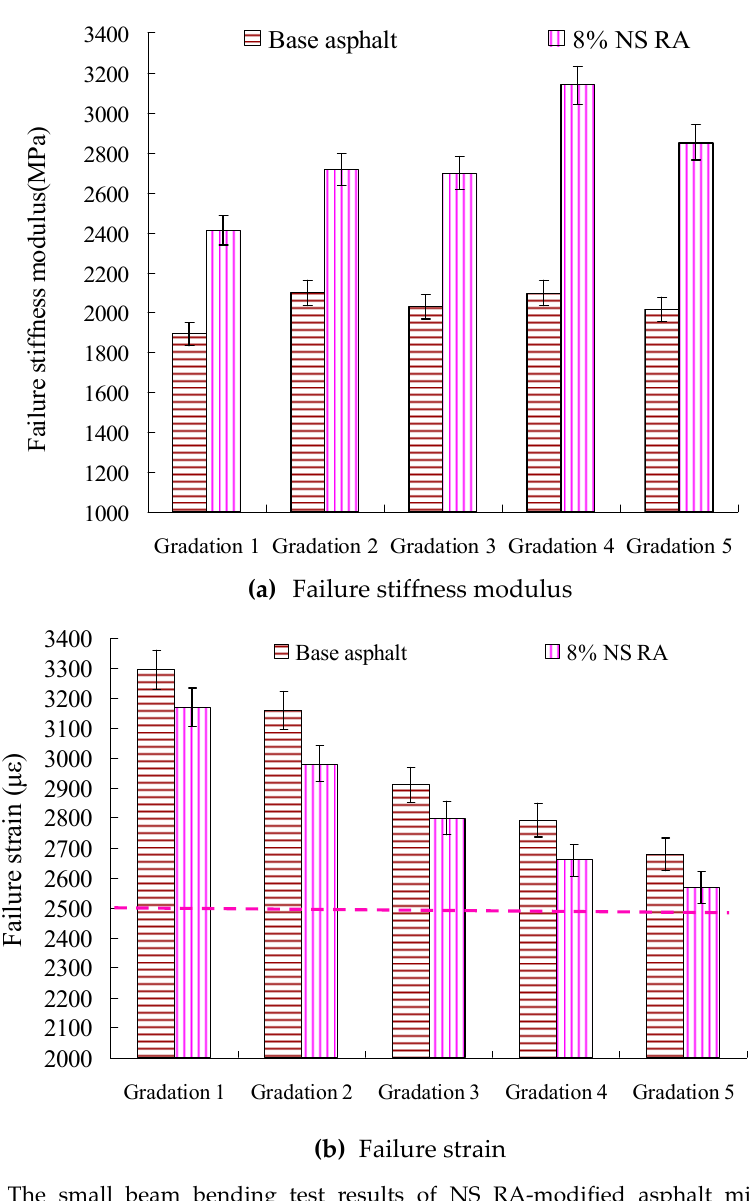
Figure 13. The small beam bending test results of NS RA-modified asphalt mixtures with different gradations.